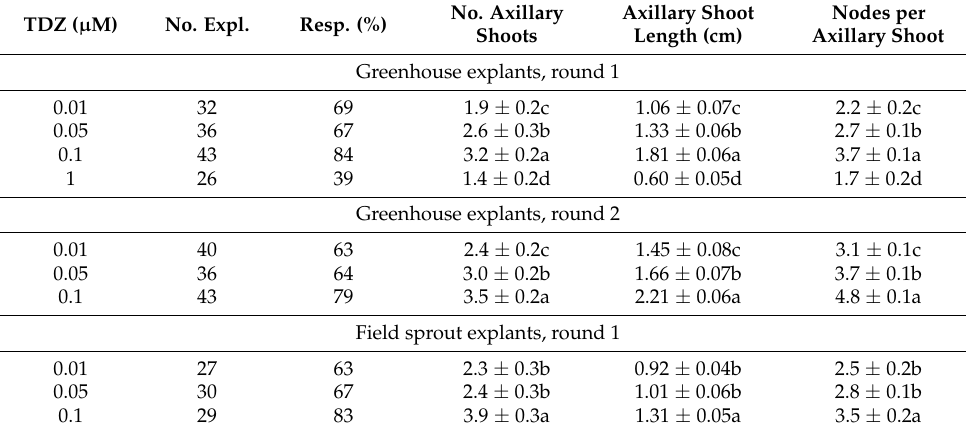
Table 2. Effect of TDZ concentrations on the multiplication of shoots from decapitated shoots taken from greenhouse-grown plants and field sprouts after 1 month of culture (round 1), and on the multiplication of newly proliferated shoots dissected from round 1 (round 2). TDZ ( µ M) No. Expl. Resp. (%)